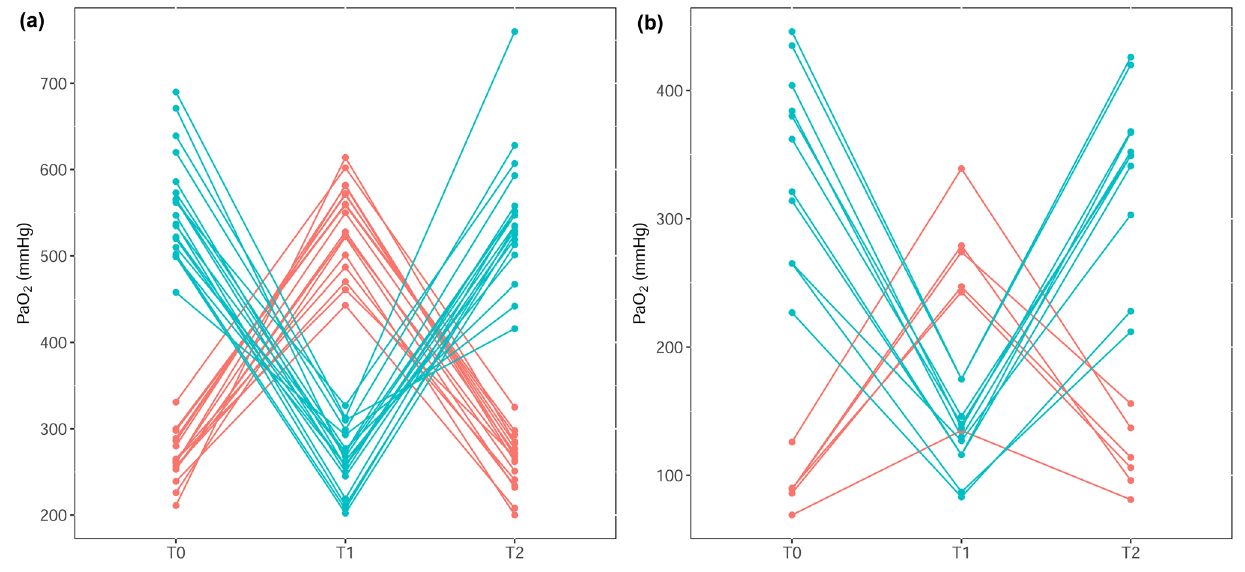
Figure 2. Change of PaO 2 according to that of fraction of inspired oxygen in ( a ) on-pump and ( b ) off-pump patients. PaO